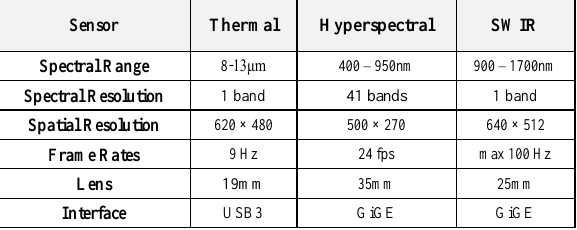
Table 1. Sensor Specifications